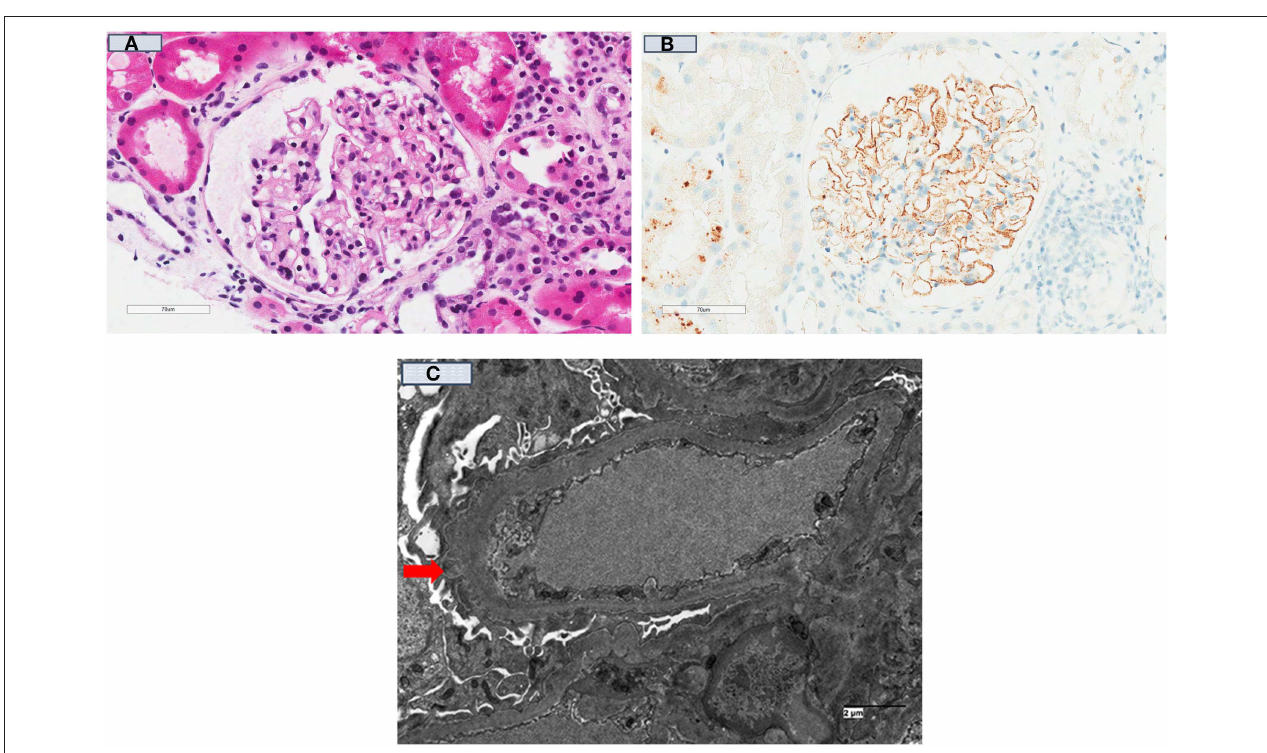
FIGURE 3 | Kidney transplant recipient who had developed recurrent idiopathic membranous glomerulonephritis 3-months post-transplant. (A) [H & E (40x)]: Kidney allograft biopsy showed a glomerulus with no significant changes and no spikes were seen on silver stains; (B) showed diffuse positive granular capillary loop